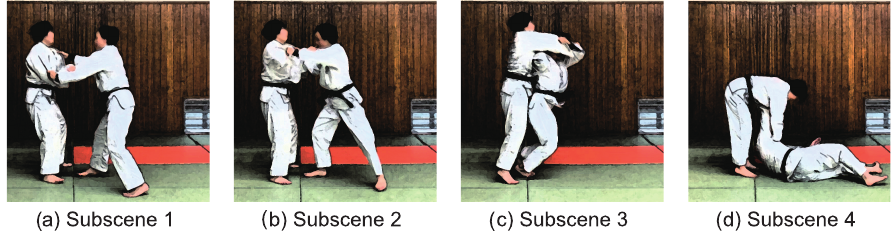
Figure 4. Four subscenes in a scene of Seoi-nage. ( a ) The subscene recognized as the posture right before the throw. ( b ) The subscene when the throw is beginning as the leg of Tori leaves the floor. ( c ) The subscene during the throw. ( d ) The subscene of Ukemi. Table 2. The numbers of scenes in the classifications of throwing techniques used for the experiments.